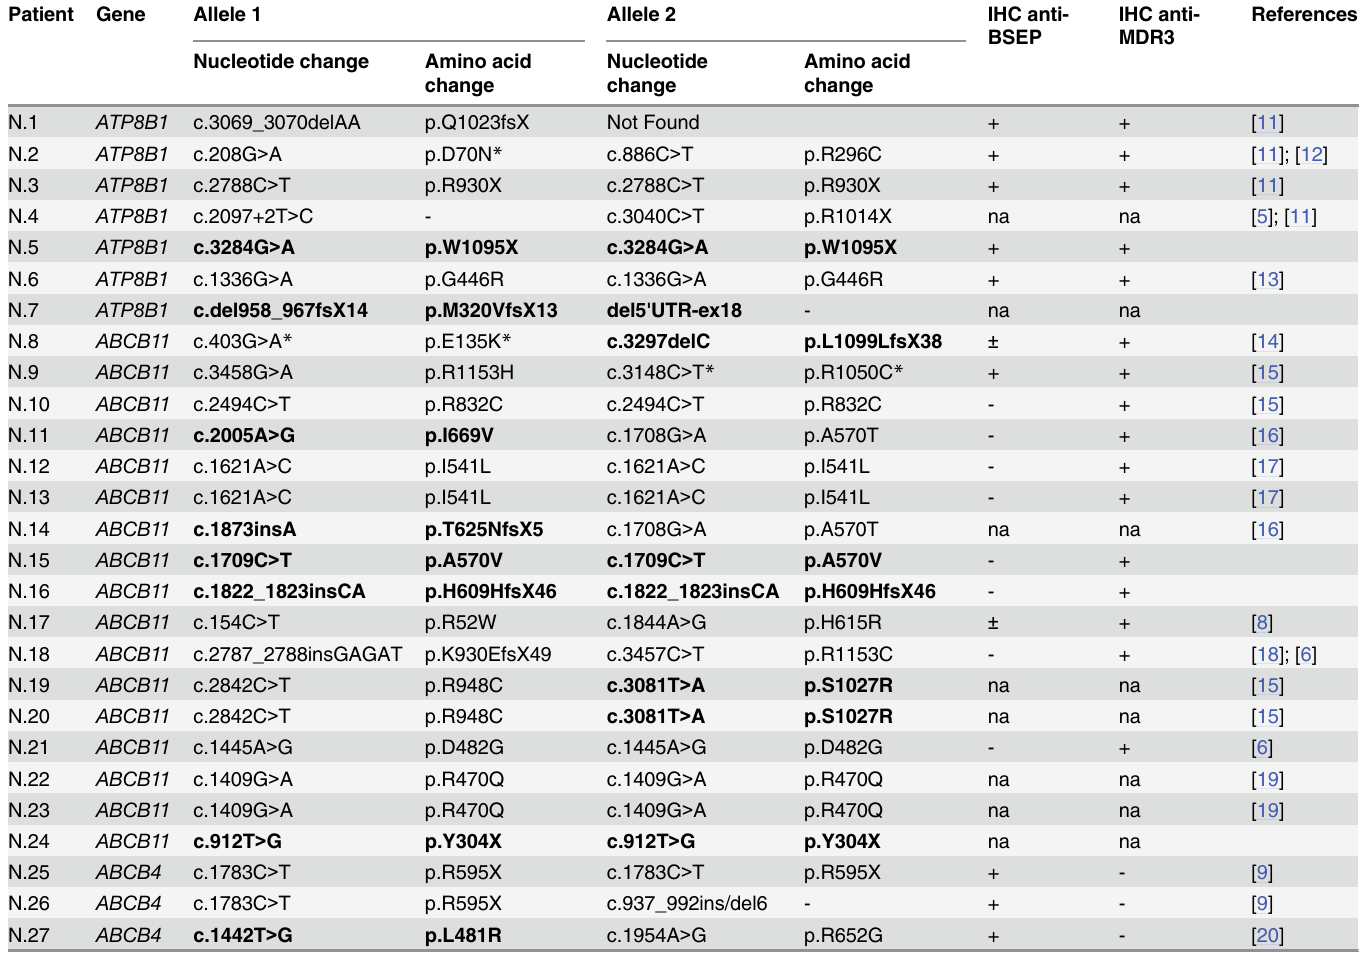
Table 2. FIC mutations and their associated